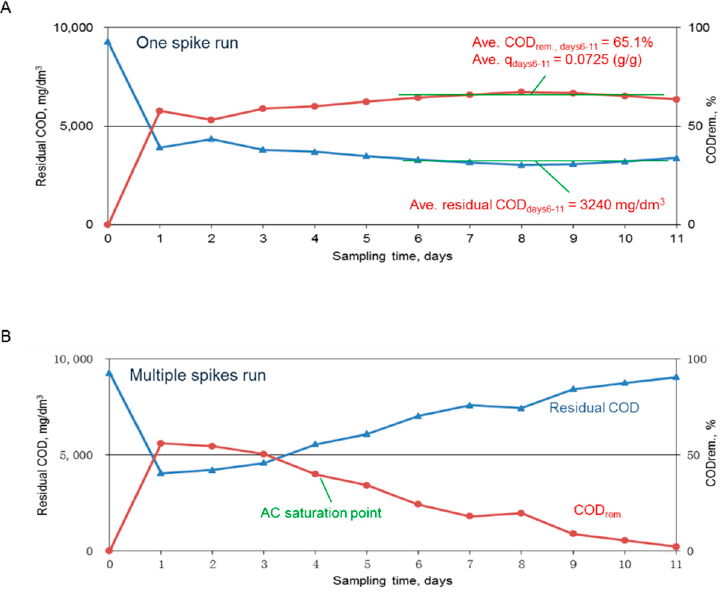
Figure 2. Plots of the residual COD over the sampling time for one spike ( A ) and multiple spikes ( B ) of the dyeing wastewater. For one spike run, the adsorption was nearly completed in one day. For the multiple spikes run, the percent removal of COD dropped to less than 50% on the 4th spike of the wastewater.